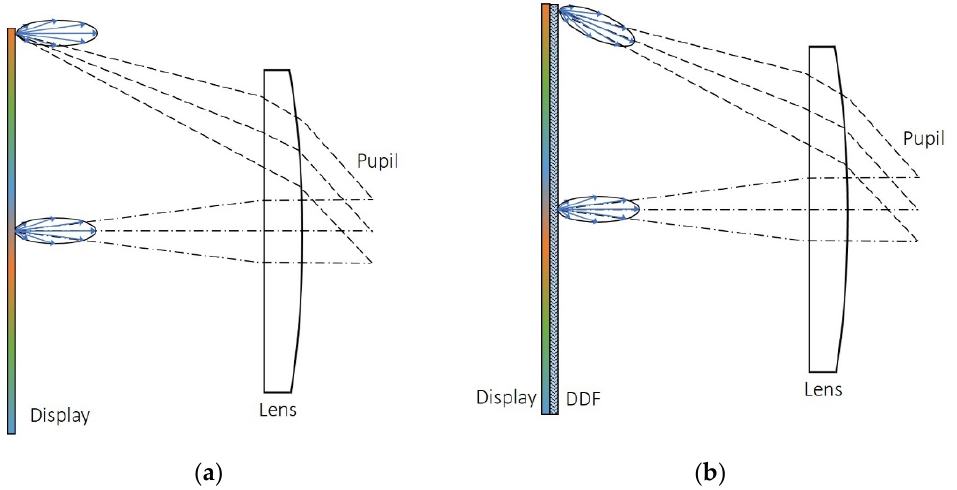
Figure 4. ( a ) Illustration of the directional VR display module; ( b ) Illustration of the directional VR display module with a laminated diffractive deflection film (DDF) on the display panel.